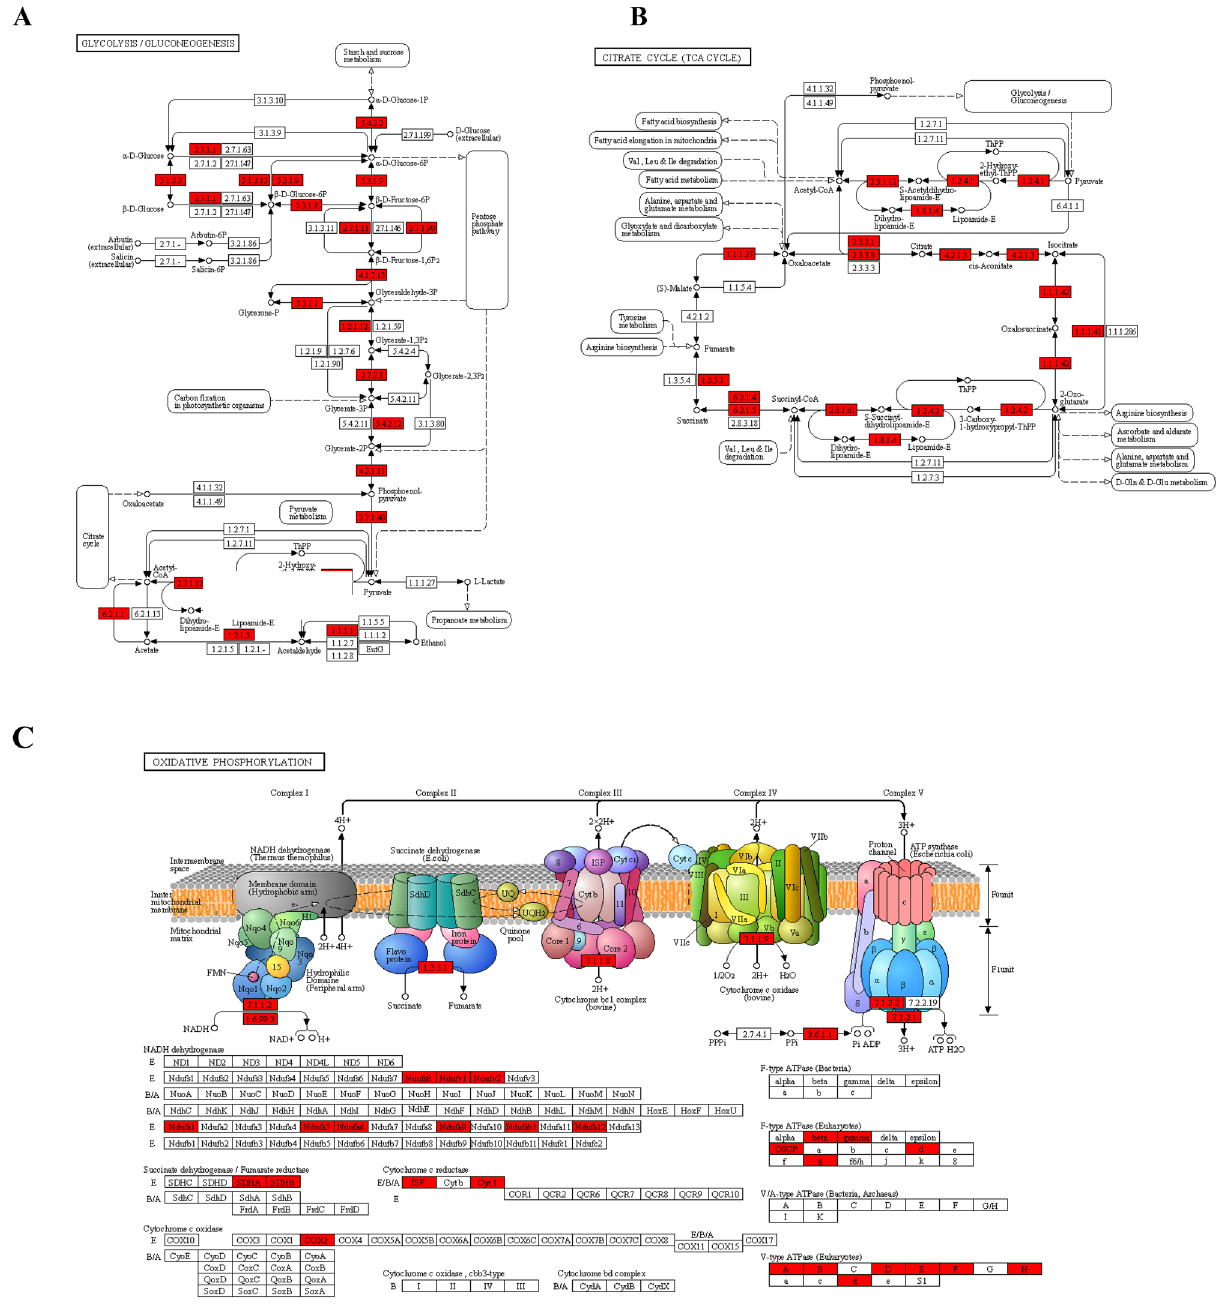
Figure 5. Representative significantly enriched carbohydrate metabolism and energy production related KEGG pathways. ( A ) Glycolysis/gluconeogenesis. ( B ) TCA cycle. ( C ) Oxidative phosphorylation. The Khib proteins are labeled in